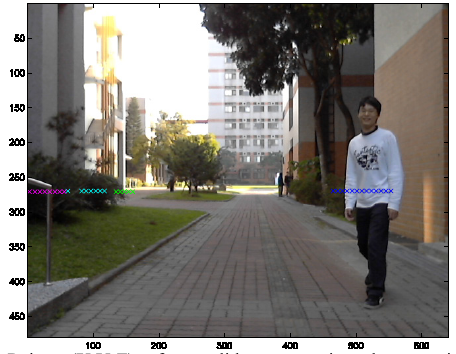
Fig. 4. Points, (X,Y,Z), of a candidate are projected onto points, (X, Y), of the 2D image. In this paper, all the training samples are scaled to and utilized at a fine resolution of 64 × 128 pixels. The training stage utilizes gradients with [−1, 0, 1] mask, 9 orientation bins, spatial binning (2 × 2 blocks of 8 × 8 pixel cells) as well as overlapping block contrast normalization (L2-norm). The training dataset is INRIA Person dataset [21], which were used in [18]. In order